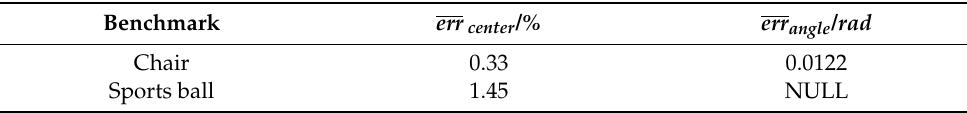
Figure 32. The localization results of the chairs and balls in the indoor scene. Table 12. Localization error statistics in the indoor test scene.